Question: Give a one-sentence summary of this figure.
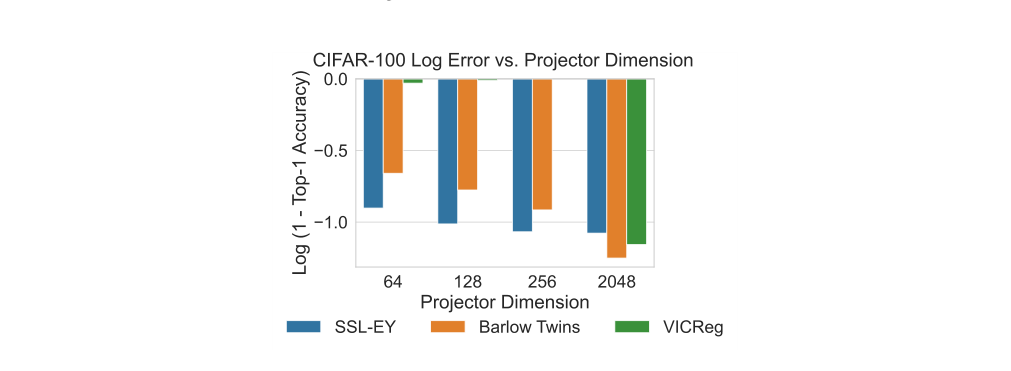
Answer: Performance of SSL-EY with reduced projector size compared to Barlow Twins and VICReg.